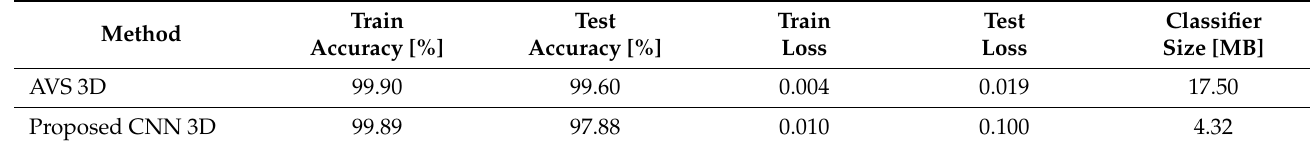
Table 4. 3D CNN classi fi ers comparison.